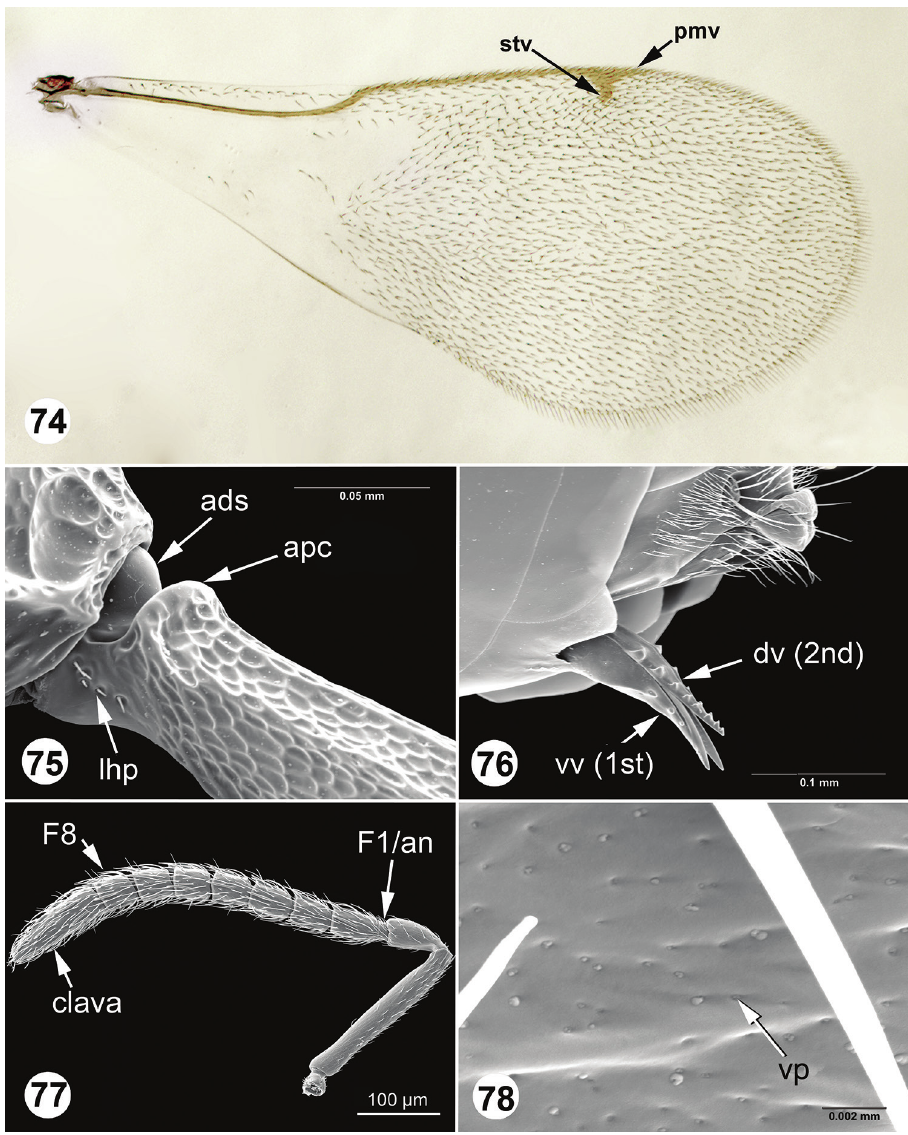
Figures 74–78. Zuparka fisheri . Paratype female: 74 fore wing 75 petiolar base 76 ovipositor. Paratype male: 77 antenna 78 pores on scape ventrally. ads = anterodorsal swelling of petiole; apc = anterior peti- olar carina; dv = dorsal (2nd) valvula; F = flagellomere; F1/an = anellus; lhp = petiolar lateral hair patch; vp = ventral pore of scape; pmv = postmarginal vein; stv = stignal vein; vv = ventral (1st) valvula.